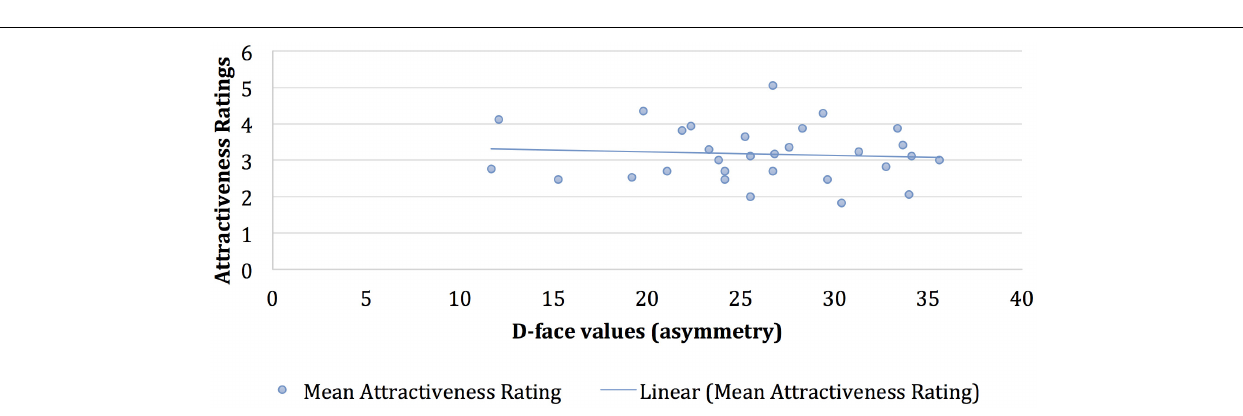
FIGURE 6 | Relationship between facial asymmetry values (D-face) and mean attractiveness ratings for 30 individuals in the face database with no makeup.